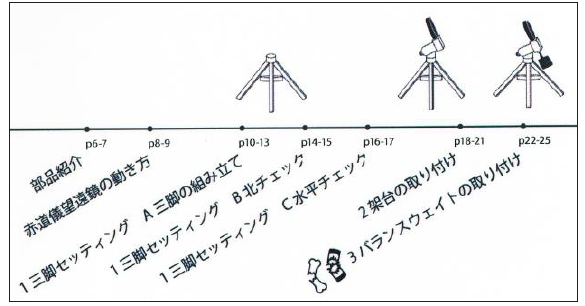
Figure 5. A part of the manual related to the developed video teaching